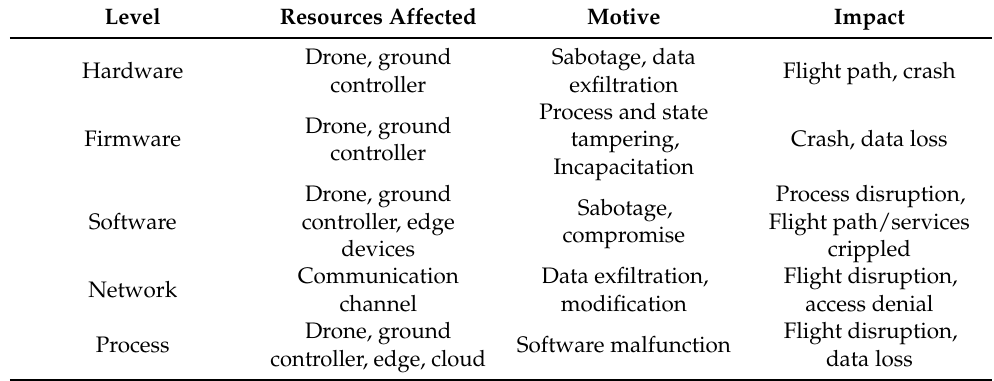
Table 1. Attack impact